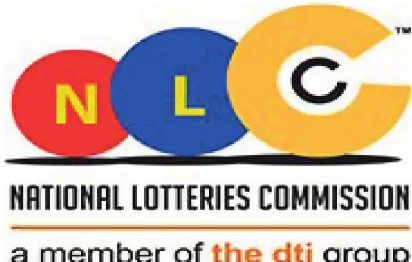
Figure 10: National lotteries commission: site two.